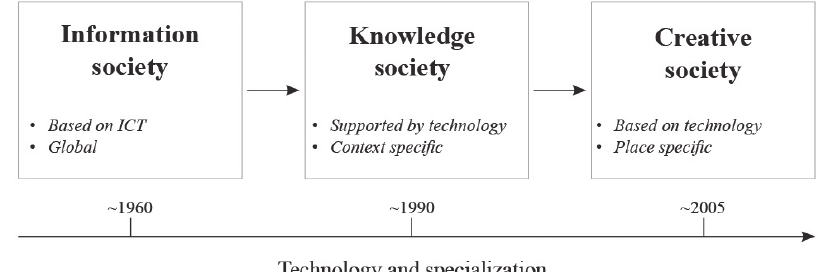
Fig. 1. Progression of information society Source: created by